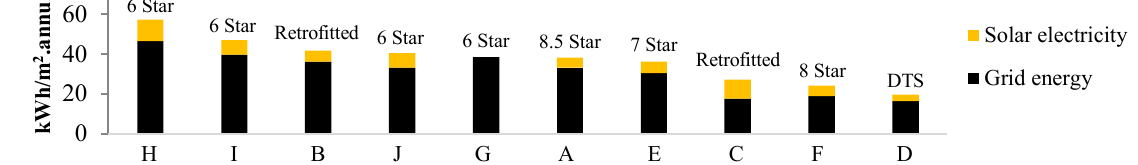
Fig. 1. Total energy use per square meter in the ten participant homes in 2015.